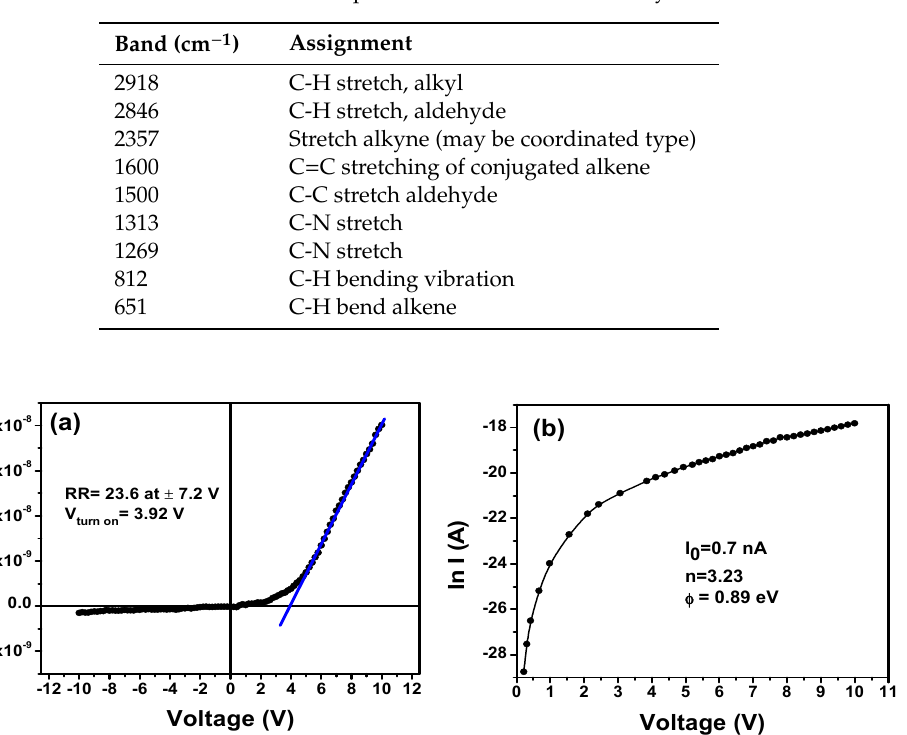
Table 1. PFB molecular composition with chemical bond dynamics.